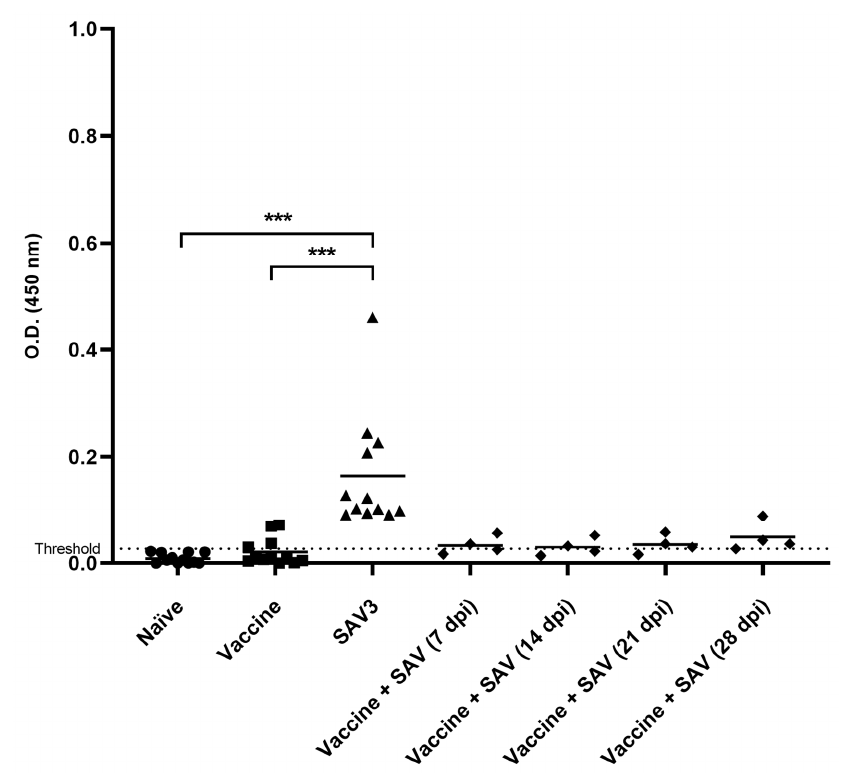
Figure 6. Scatter plot of specific serum antibody (IgM) levels measured by ELISA ( n = 12). Depicted are optically density (OD) values (450 nm) of rainbow trout sera (diluted 1:100) from naïve fish, vaccinated fish (63 dpv), SAV3 challenged fish (63 dpi) and vaccinated fish at 7, 14, 21, and 28 dpi. Signif. codes: ‘***’ p < 0.001 comparing all treatment groups to the control. Bar = mean. Threshold = (average naïve fish OD) + (2× SD).